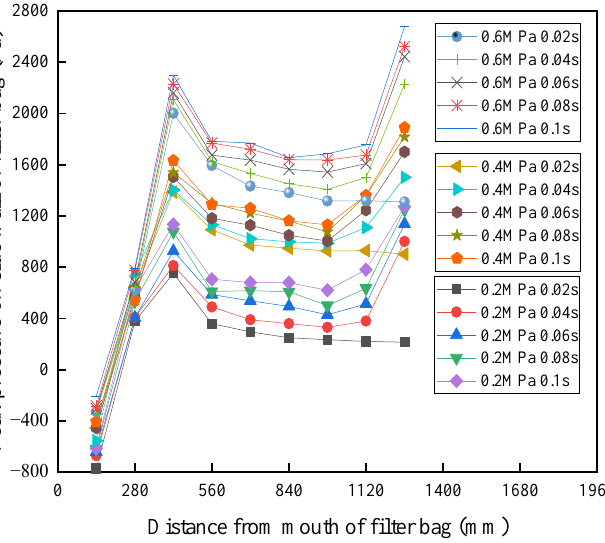
Figure 7. The peak value of the side wall pressure of the filter bag under different operating param- eters.